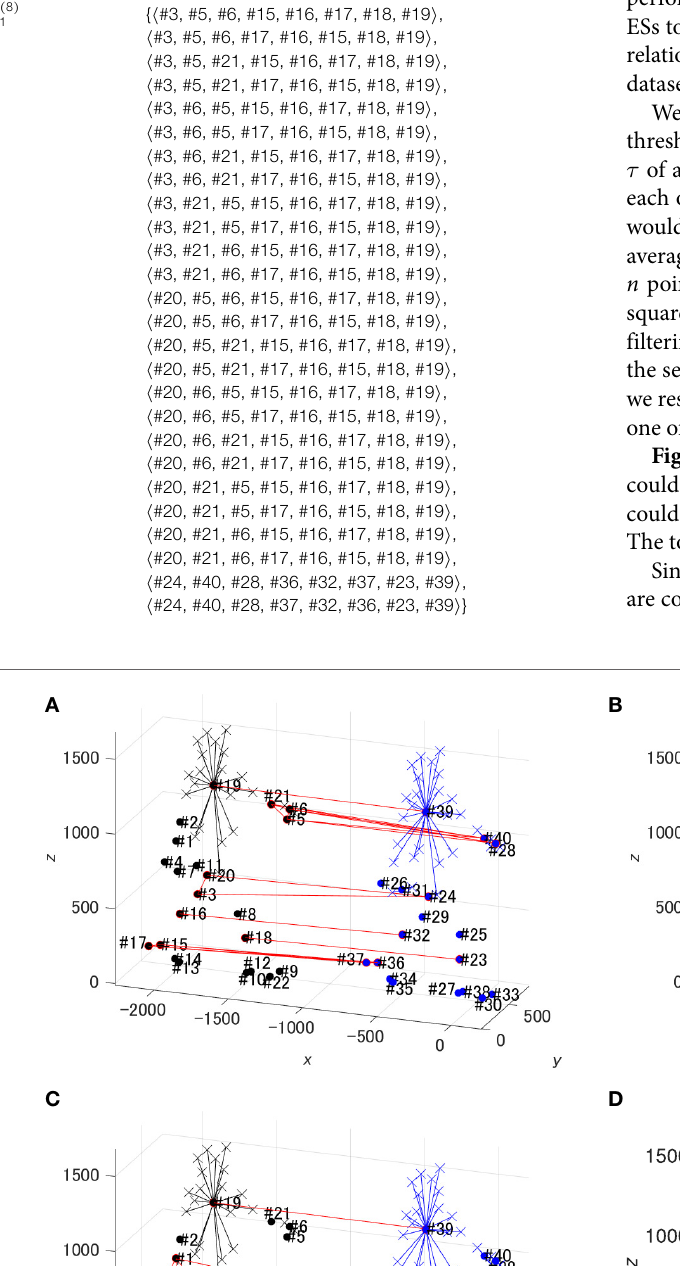
Frontiers in Robotics and AI |